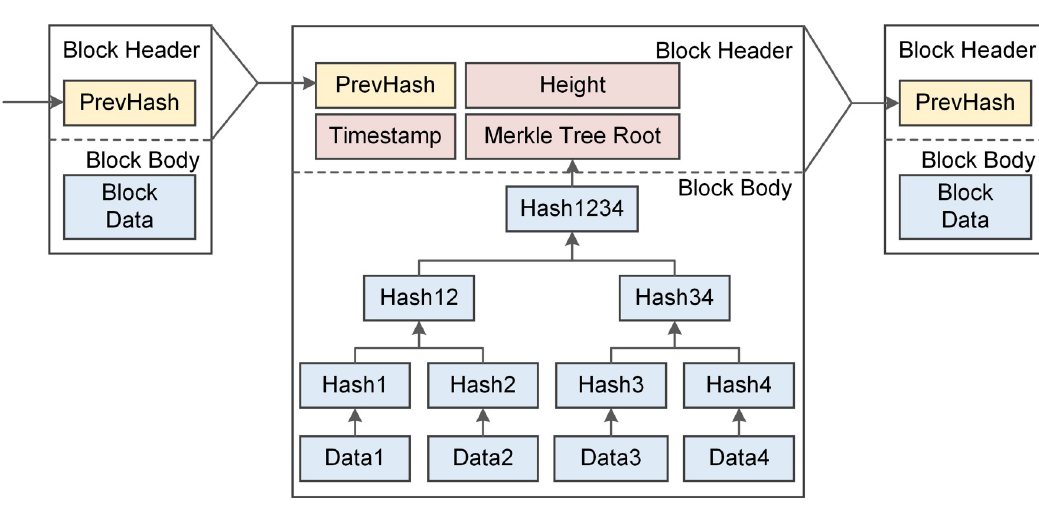
Fig 3. Block structure of the blockchain.